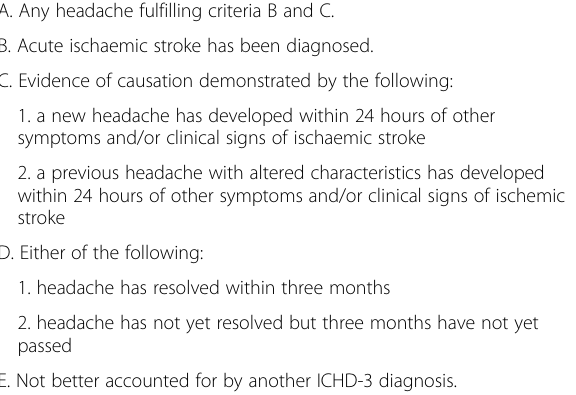
Table 3 Alternative diagnostic criteria for acute headache